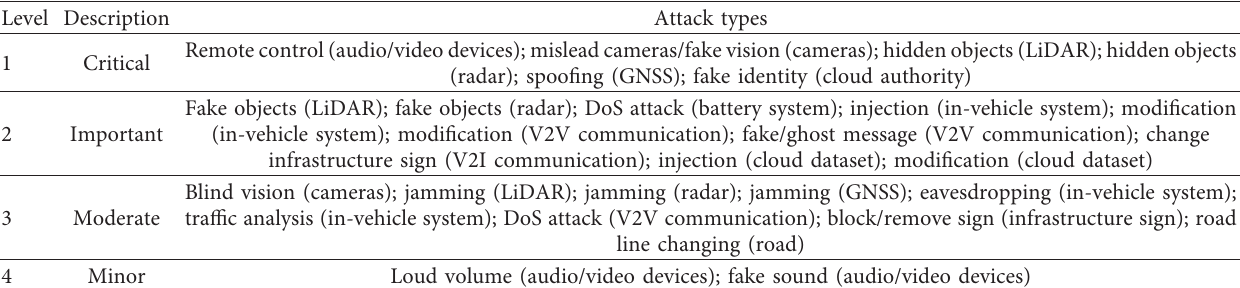
Table 5: Categories of severity of